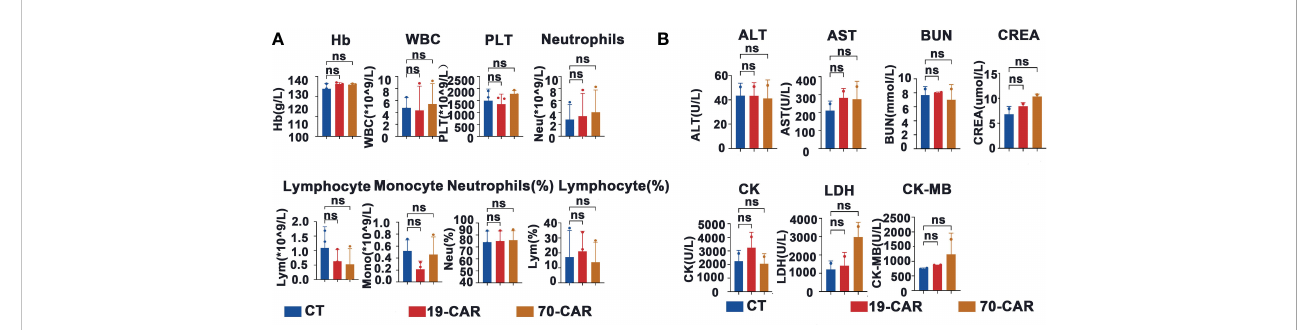
FIGURE 5 Evaluation of hematologic toxicity of CD70-CAR-T cells in vivo . (A) , Venous blood of the mice (n=3) treated with CAR-T or control T cells were collected on day 10. The data of hemoglobin (Hb), white blood cells (WBC), platelet (Plt), lymphocytes (Lym), neutrophils (Neu), and monocytes (Mono) were shown, (B) , The data of blood biochemistry including alanine aminotransferase (ALT), aspartate aminotransferase (AST), blood urea nitrogen (BUN), creatine kinase (CK), creatine kinase-MB (CK-MB), creatinine (CREA) and lactate dehydrogenase (LDH) were shown. One-way ANOVA analysis; ns means no signi fi